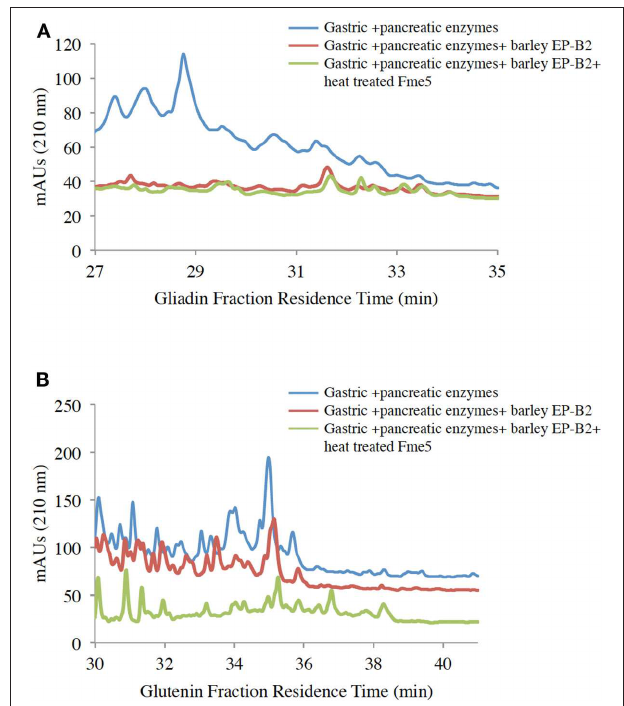
FIGURE 4 | RP-HPLC (reversed-phase high-performance liquid chromatography) analysis of wheat gliadin (A) and glutenin (B) fractions. Before HPLC, gliadins were sequentially treated with digestive enzymes (pepsin, trypsin, chymotrypsin, elastase, and carboxypeptidase (A) , EP-B2, and Fm-PEP variant “Fme5.” Subsequently, pancreatic enzymes were added to the solution after pH adjustment. The control was wheat gliadins digested only with gastric and pancreatic enzymes (blue line), and the treatments were wheat gliadin digestion with gastric and pancreatic enzymes supplemented with (i) EP-B2 (red line), or (ii) EP-B2 and heat-treated (90 ◦ C for 10min) Fm-PEP (green